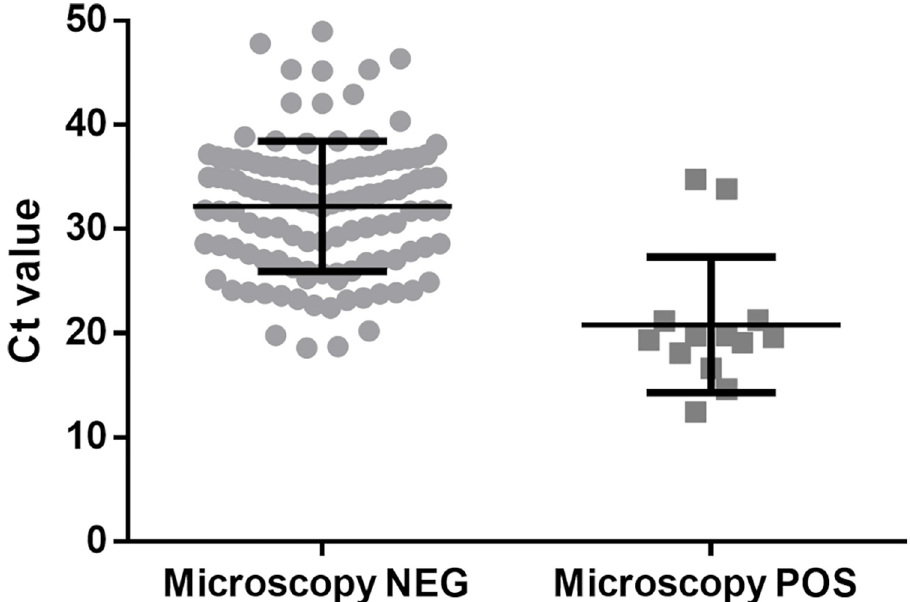
Fig 3. Kinetoplast DNA PCR cycle threshold (Ct) values of microscopically negative ( n = 191) and positive ( n = 14) smears. The unpaired t-test showed that Ct values are significantly different (p < 0.001).